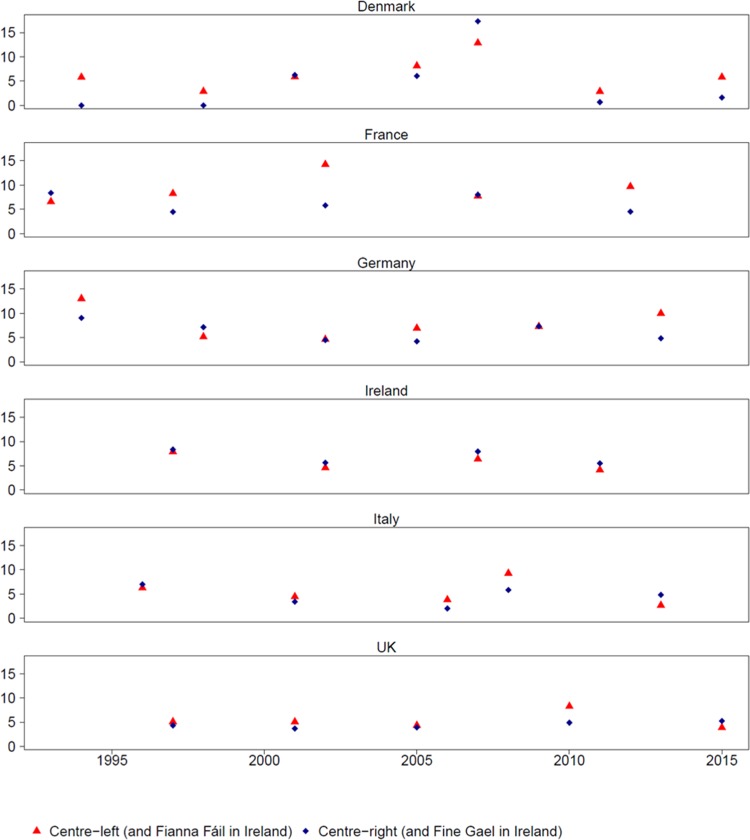
Pro-climate content.